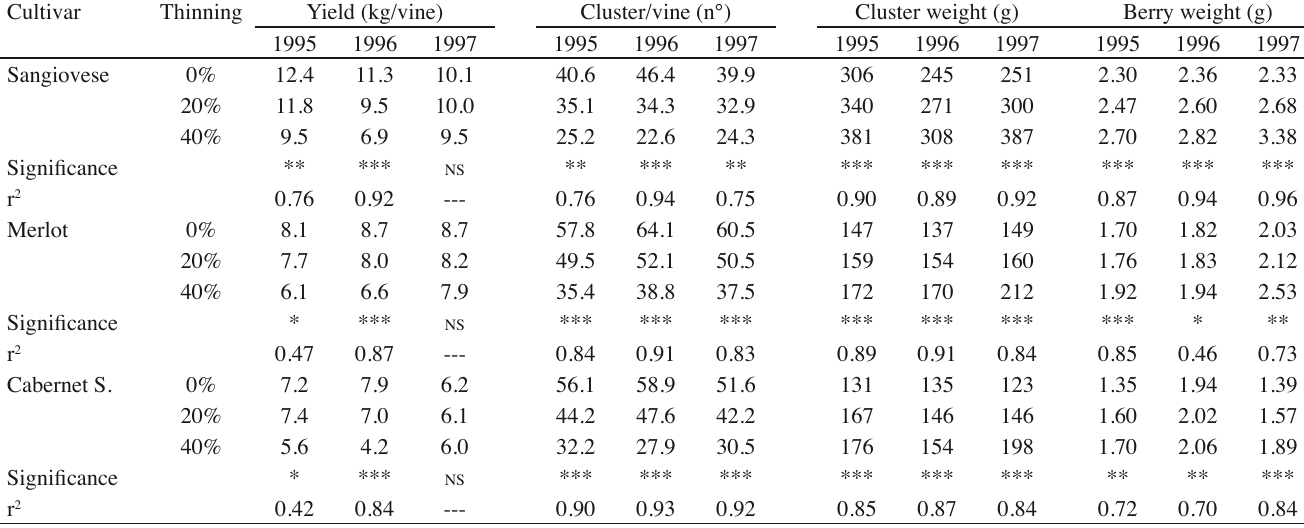
Table 2 - Effects of cluster thinning on yield and cluster characteristics in Sangiovese, Merlot and Cabernet Sauvignon grapevine cultivars Cultivar Thinning Yield (kg/vine)